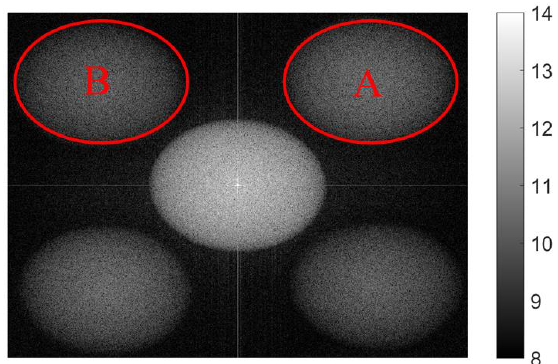
Figure 7. Spectrum of the recorded interferogram obtained by Fourier transformation.